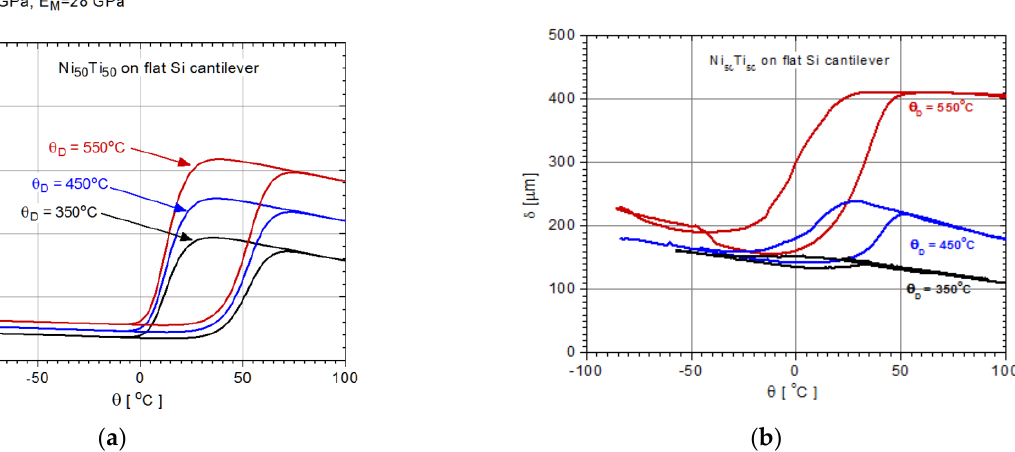
Figure 10. Deflection vs. temperature of the free end of similar bimorph cantilevers, with Ni–Ti films deposited on Si substrate at different temperatures (350 °C, 450 °C, and 550 °C): ( a ) model predictions; ( b ) experimental data.